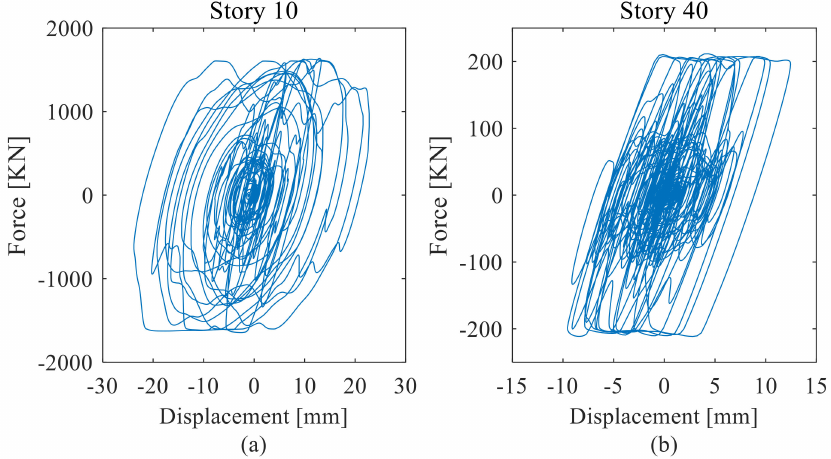
Figure 17. Damper force deformation relations for GM#32 at ( a ) story 10 and ( b ) story 40